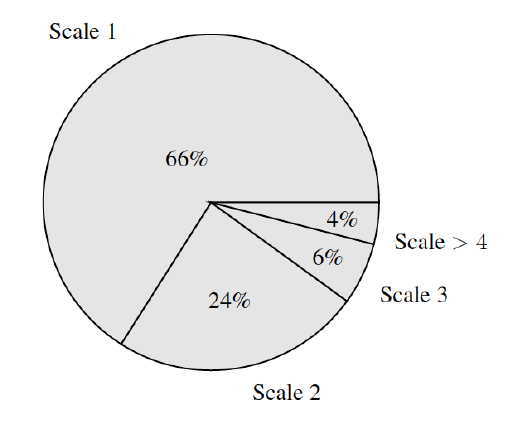
Figure 5. Proportion of processing time for each scale. Most of the time is required by the aggregation procedure on the first